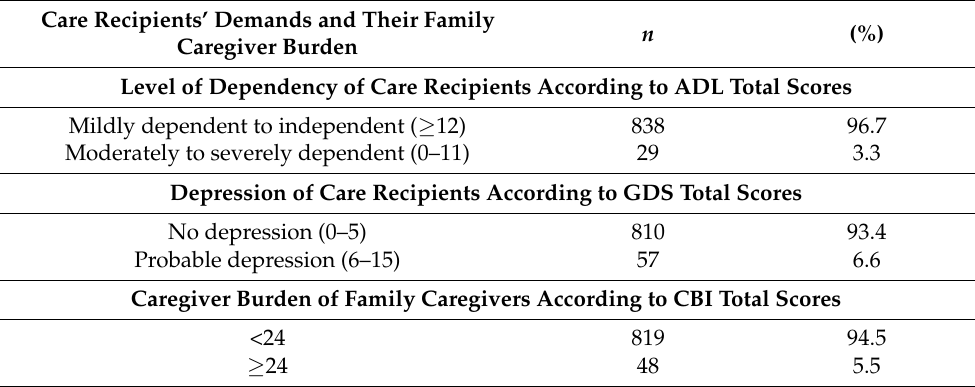
Table 2. Care recipients’ demands and their family caregiver burden, Maehia subdistrict, Chiang Mai, Thailand, 2019.